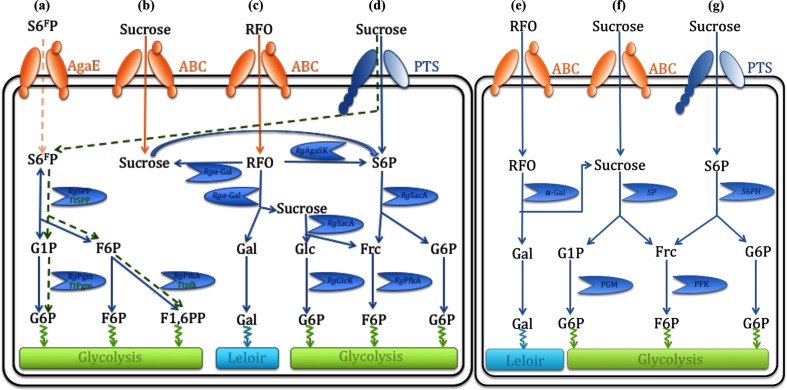
Hypothetical sucrose, sucrose 6-phosphate and sucrose 6F-phosphate metabolic pathways in the Ruminococcus gnavus E1, T. thermolyticum and Lactobacillales bacteria (adapted from Bruel et al. and Verhaeghe et al. [24, 32]). Pathways for uptake and catabolism in the Ruminococcus gnavus E1 clade of (a) S6FP, (b) and (d) sucrose, and (c) RFO, and in the lactobacillales bacteria of (e) RFO, and (f) and (g) sucrose. The T. thermolyticum S6F P (a) metabolic pathway proposed by Verhaeghe et al., in 2014, appears in green, whereas the sucrose pathways follow the (f) and (g) models. RgSPP, sucrose 6F-phosphorylase; RgAgaSK, α-galactosidase/sucrose kinase; Rgα-Gal, α-galactosidase; RgPfkA, 6-phosphofructokinase; RgPgm, phosphoglucomutase; RgSacA, sucrose 6P hydrolase; RgGlcK, glucose kinase; SP, sucrose phosphorylase; S6PH, sucrose 6-phospho-hydrolase; AgaE and ABC, ABC transporters; PTS, phosphoenolpyruvate-dependent sugar phosphotransferase system; S6FP, sucrose 6F-phosphate; S6P, sucrose 6-phosphate; RFO, raffinose family oligosaccharide.